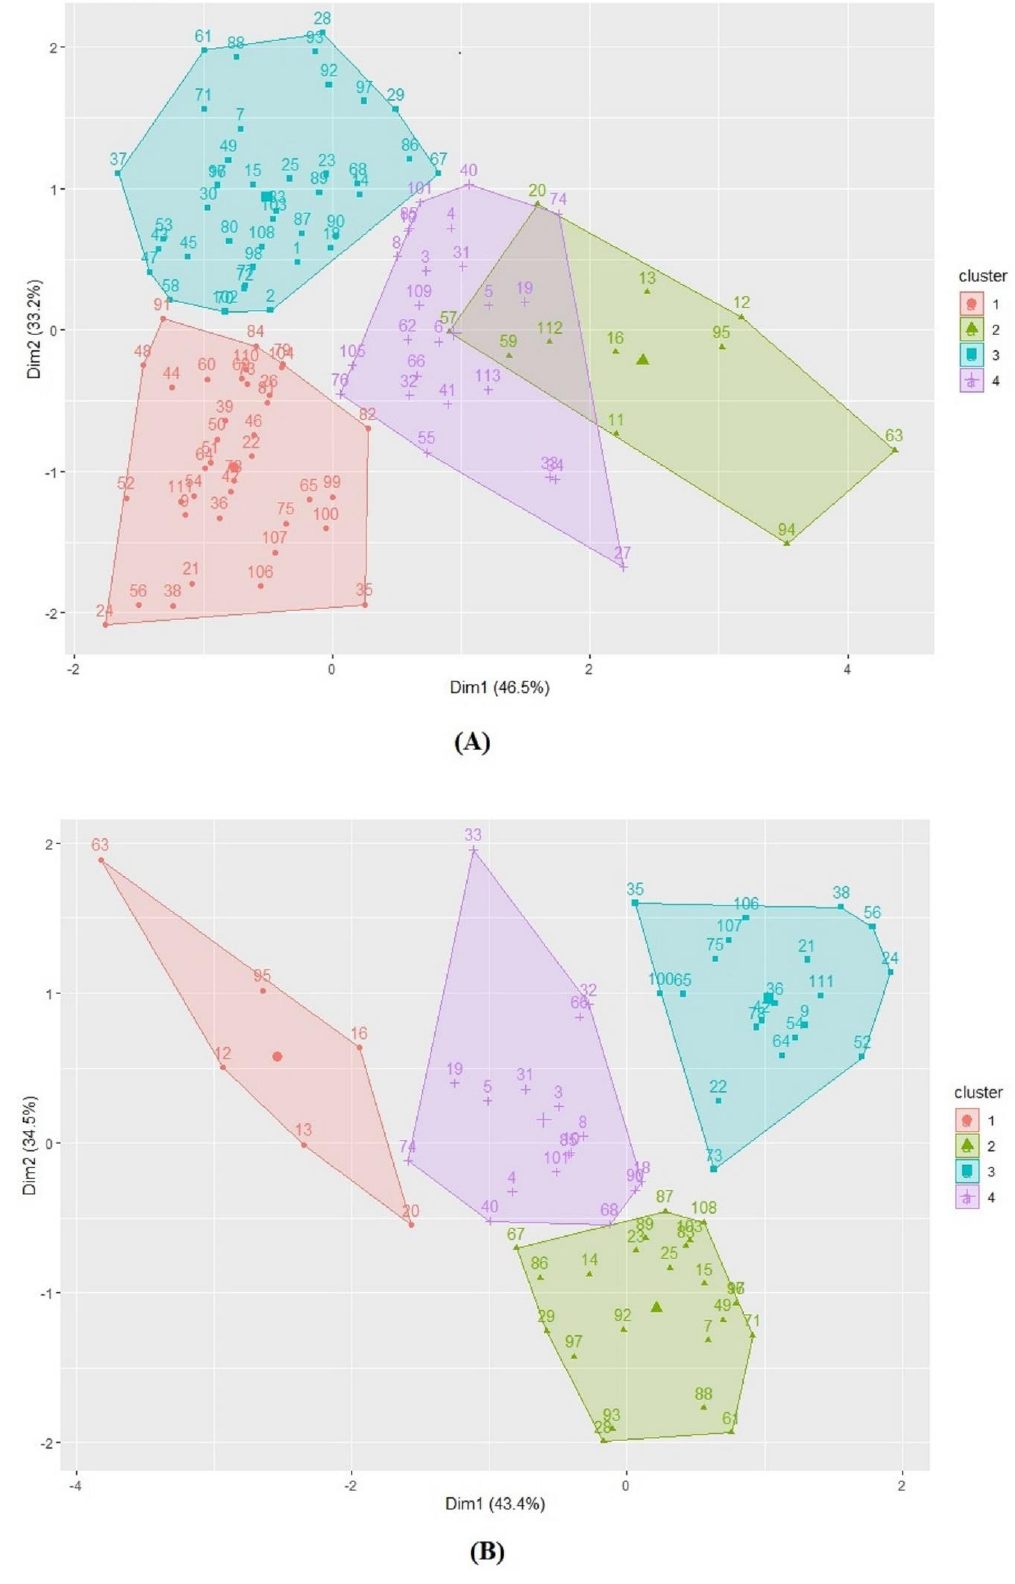
Figure 7. ( A ) Clustering of 113 wheat genotypes representing the contribution of 3 factors: Plant height (PH), days to heading (DH) and the area under disease progression curve (AUDPC); ( B ) clustering of 66 wheat genotypes (46 R and 20 S) representing the contribution of 3 factors: plant height (PH), days to heading (DH) and the area under disease progression curve